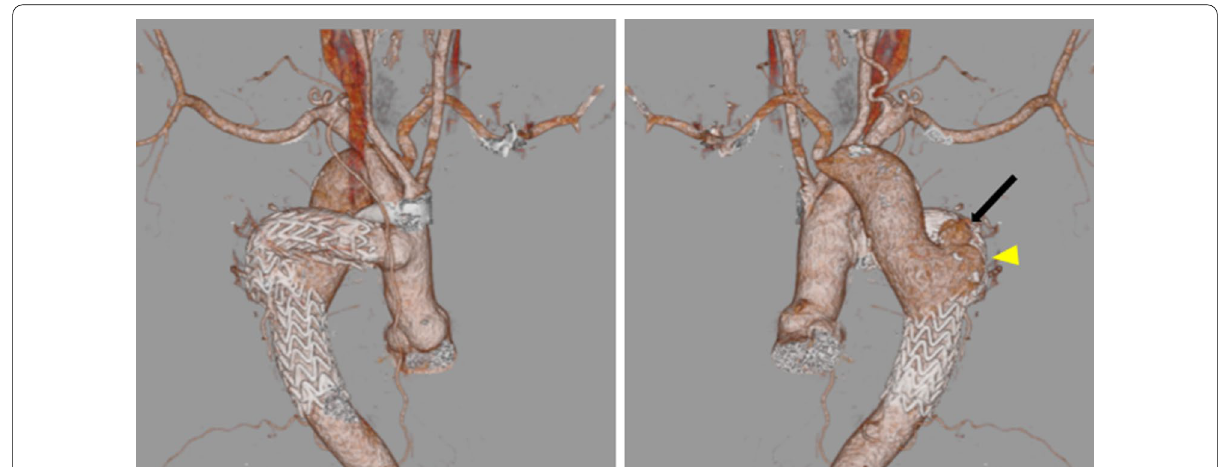
Fig. 1 Preoperative computed tomography three-dimensional (3D) reconstruction. Anterior ( a ) and posterior ( b ) views show the right aortic arch and distal anastomotic aneurysm and contrast medium extravasation outside the aneurysm (black arrow). A small extension (similar to Kommerell diverticulum) was found in the posterior ( b ) view (yellow